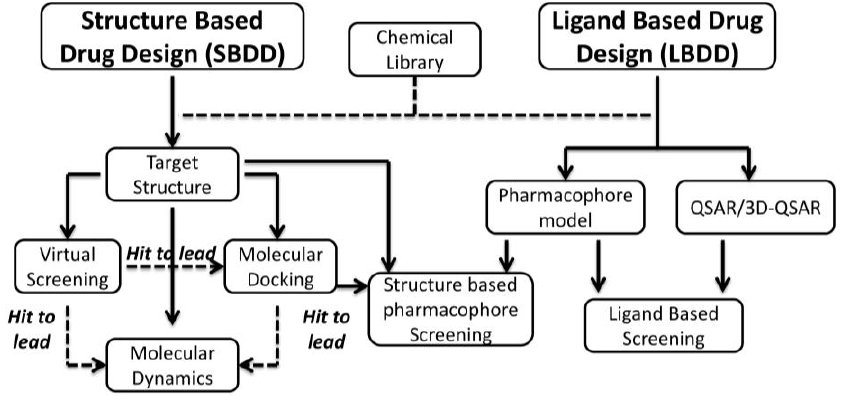
Figure 1. Schematic representation of in silico rational drug design techniques.